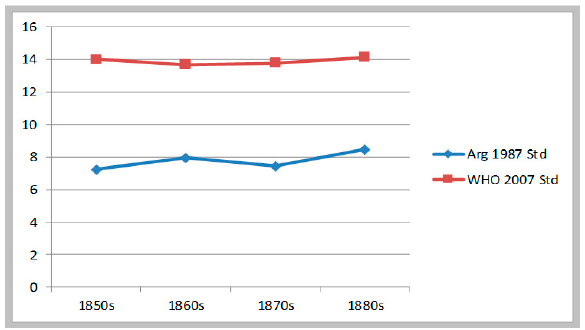
Figure 1. Evolution of moderate & severe stunting. National Guards b1855–1883 (in%).